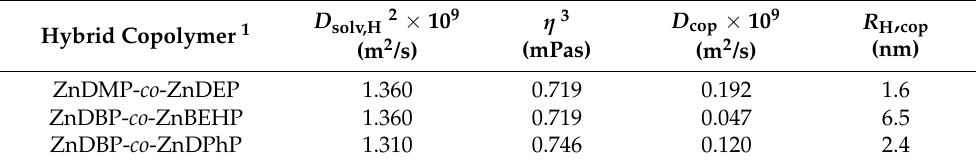
Table 4. The results of 1 H DOSY NMR measurements carried out at 25 ◦ C for the 5 mg/mL solutions of the ZnDOPs-based hybrid copolymers in C 6 D 6